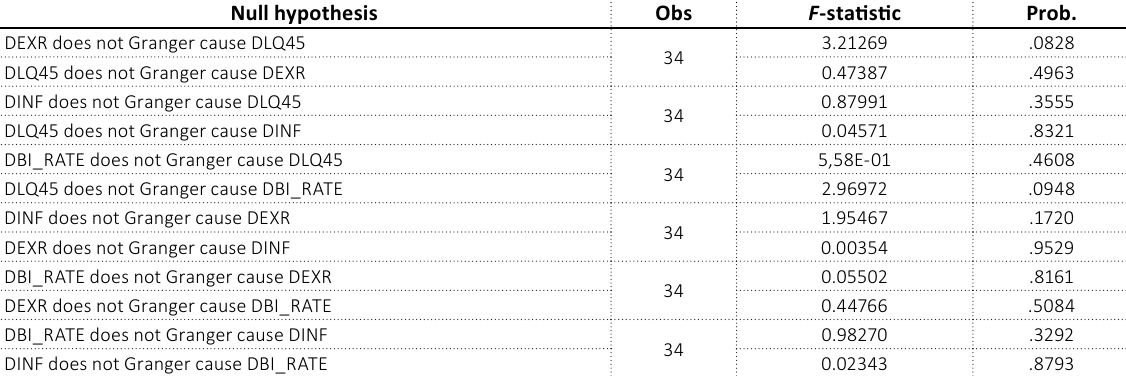
Table 3. Granger causality test